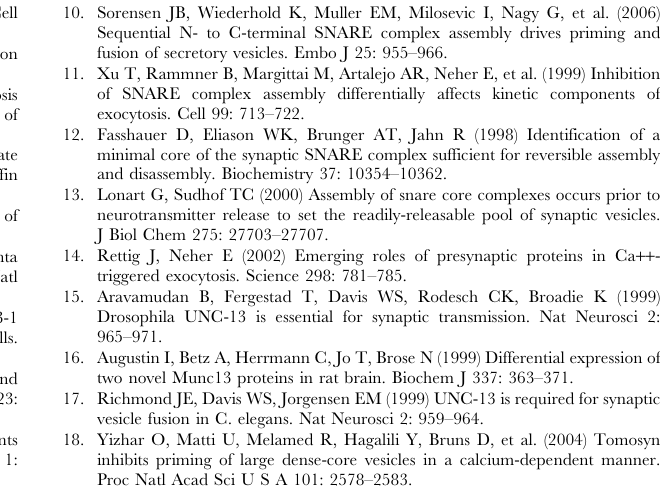
pixels apart. The procedure was repeated for each vesicle in each frame and vesicle trajectories were thus collected for analysis. Found at: doi:10.1371/journal.pone.0002694.s002 (10.71 MB TIF) Figure S2 Statistical analysis of mobility distributions (a). Windowed velocity calculation of a single vesicle from a control cell, as detailed in Figure 1. (b). Mean histogram of velocity values for 35 vesicles from a single control cell. (c). Mean histogram of the logarithms of velocity values for the same 35 vesicles as in b. Dashed red line represents fitting to a normal distribution model. (d). Cumulative distribution function of velocity values for the vesicle shown in a (black), fitted with a log-normal distribution model (dashed red line). Figure S3 Mobility correction with fixed beads (a). Mobility cdf of fixed 220-nm beads imaged at 10 Hz at varying laser intensities (each line represents the mean cdf of a group of beads imaged at a specific laser intensity as shown in the legend; n= 31 beads in each condition). (b). The mean apparent mobility of each bead was plotted against its fluorescence intensity (gray dots). Red line represents curve-fitting to the data as detailed in the Supplemen- tary Methods. (c) Mobility cdfs calculated for the same bead groups shown in a, after correction for noise-related mobility. Note that apparent mobility is strongly reduced and the differences between the apparent mobilities of the beads under different illumination intensities are significantly smaller. (d). Mean mobility values of vesicles from all control cells measured in our experiments, plotted against their mean fluorescence intensity before (black dots), and after (red dots) correction. Note that vesicle fluorescence was relatively strong, such that the maximal mobility artifact before correction is on the order of 20 nm s 2 1. Found at: doi:10.1371/journal.pone.0002694.s004 (11.06 MB